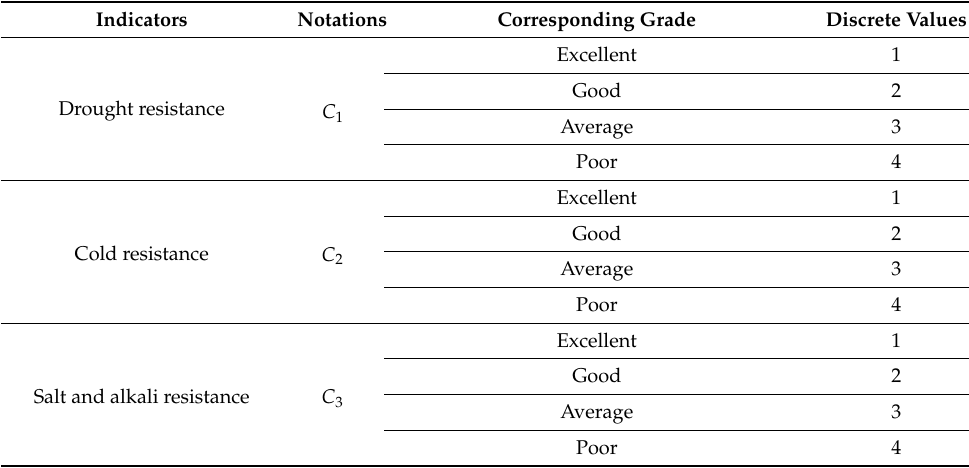
Table 2. The classification interval table of the comparison